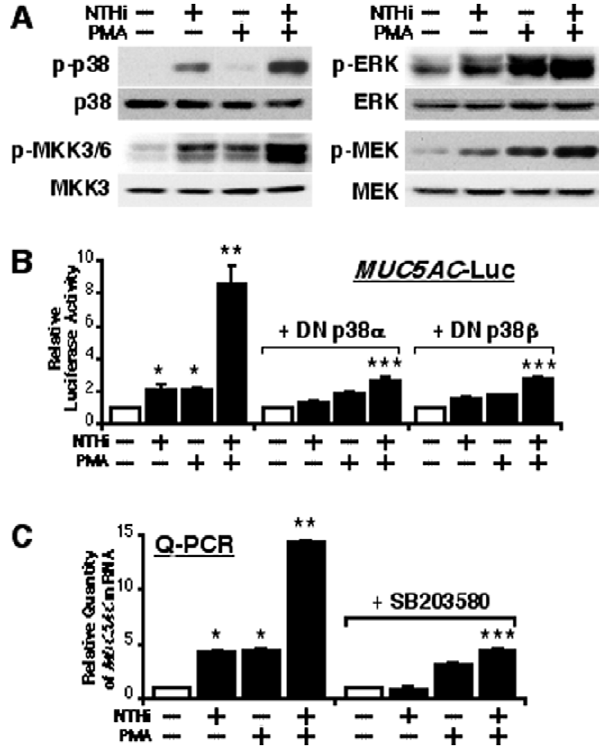
Figure 2. PMA synergistically enhances NTHi-induced MUC5AC expression via MKK3/6-p38 MAPK pathway. ( A ) PMA synergisti- cally enhanced NTHi-induced phosphorylation of p38 MAPK and MKK3/ 6, but not ERK and MEK1. ( B ) The synergistic induction of MUC5AC transcription by NTHi and PMA was inhibited by overexpressing DN mutant forms of p38 a and p38 b in human epithelial cells, as assessed by MUC5AC-dependent promoter Luciferase assay. Cells were trans- fected with 0.8 m g of DN p38 a , DN p38 b , or control vector, and treated with NTHi with or without PMA. Relative luciferase activity of MUC5AC was measured from the cell lysate. ( C ) SB203580, a specific inhibitor for p38 MAPK signaling, attenuated the synergistic induction of MUC5AC expression by NTHi and PMA at the mRNA level as assessed by Q-PCR. Cells were pre-treated with 10 m M of SB203580 or vehicle control, and treated with NTHi with or without PMA. mRNA expression level of MUC5AC was measured by Q-PCR. Values are the means 6 S.D. (n=3). *p , 0.05 vs. control; **p , 0.05 vs. NTHi alone; ***p , 0.05 vs NTHi with PMA in control vector transfected ( B ) or vehicle treated ( C ) cells. The data shown are representative of three independent experiments. 2 , absence of; + , presence of; DN, dominant negative; NTHi, nontypeable Haemophilus influenzae .